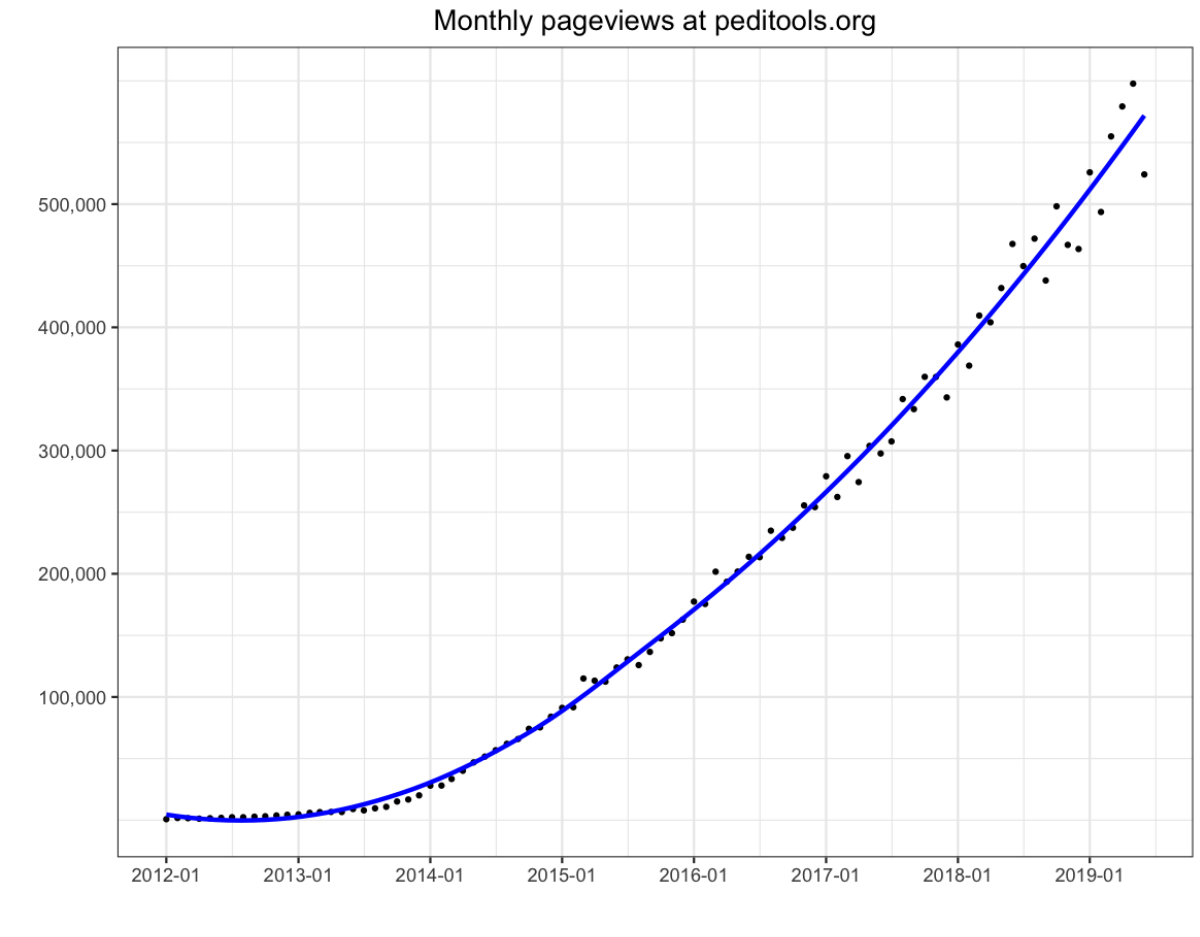
Figure 3. PediTools (https://peditools.org/) website overall monthly pageviews over time from public launch in January 2012 through June 2019.